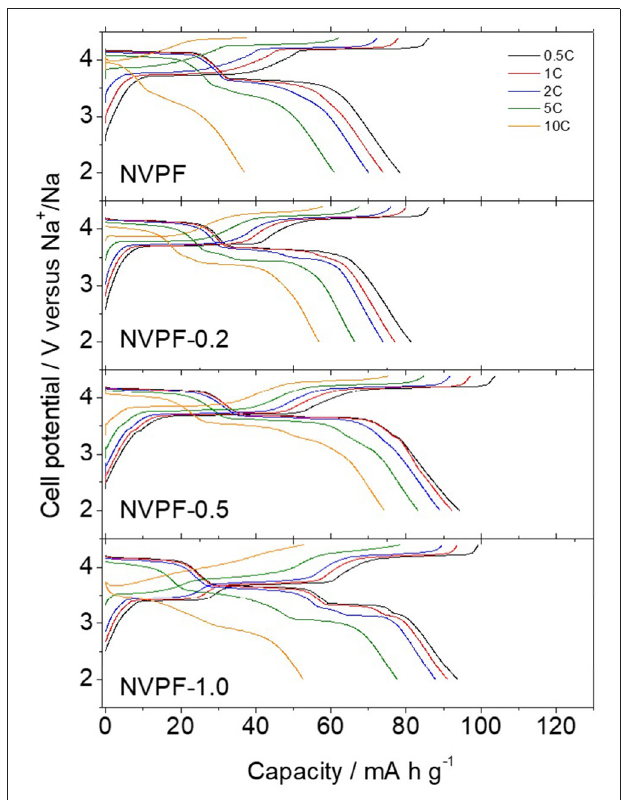
FIGURE 5 | Galvanostatic charge and discharge curves recorded from sodium half-cells cycled at increasing C rates.